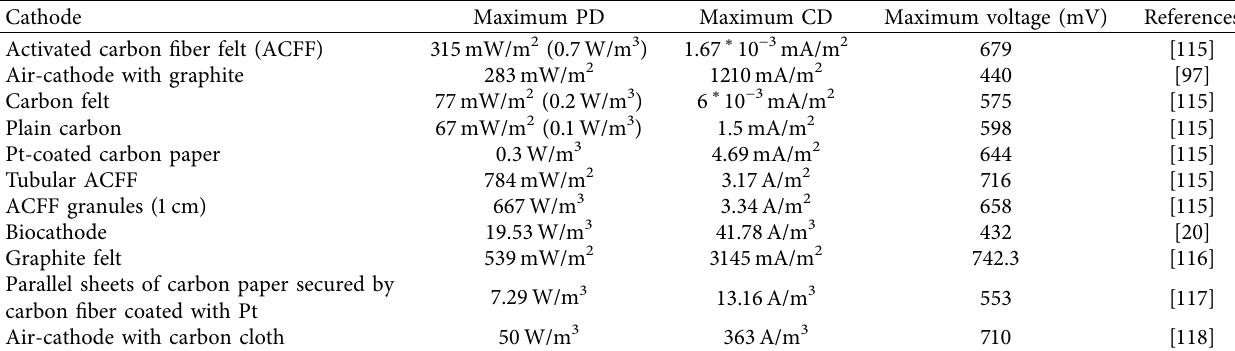
Table 3: List of electrodes used in MFC with maximum power, voltage, and current